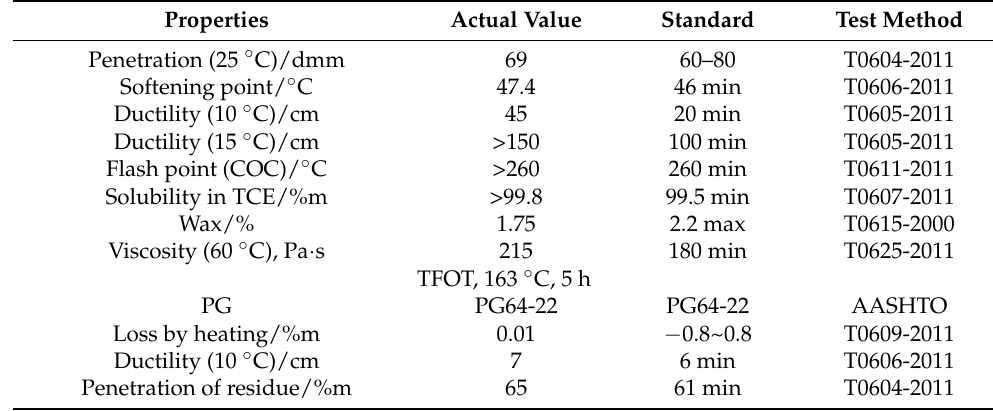
Table 3. The properties of Shell asphalt binder.